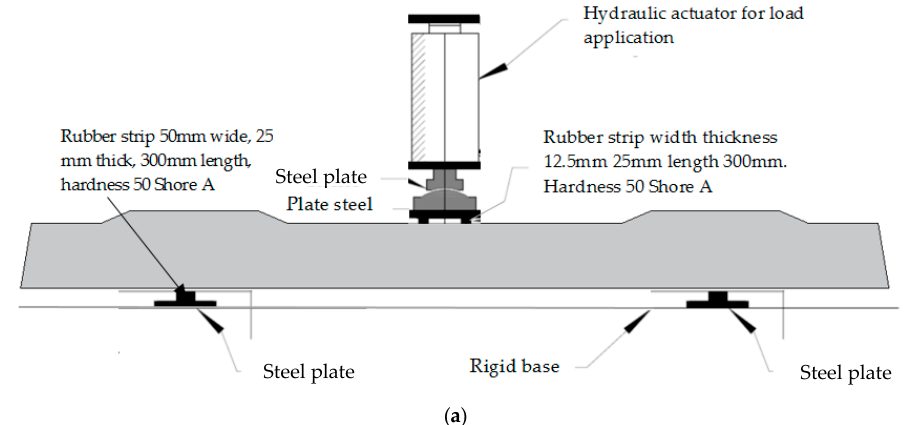
Table 1. Results of the concrete extraction and compression